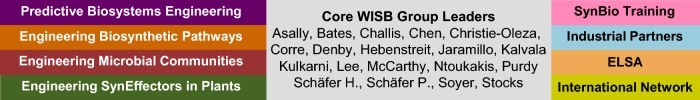
WISB: personnel and activitiesThe core academic community comprises academics from the Departments of Life Sciences, Chemistry, Computer Science, Engineering and Education Studies. In addition, WISB comprises Associate Members from the University of Warwick, Honorary Members from other institutions, RCDFs, postdoctoral associates and PhD students and also trains and supports an iGEM team each year. More information can be found on our website: http://www.wisb-uow.co.uk.